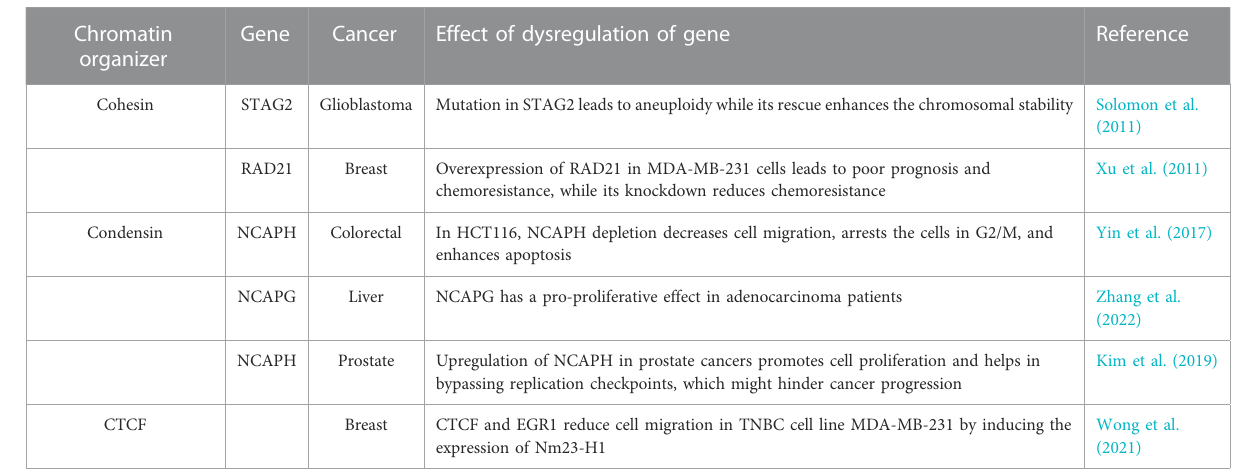
TABLE 1 Role of chromatin organizers in